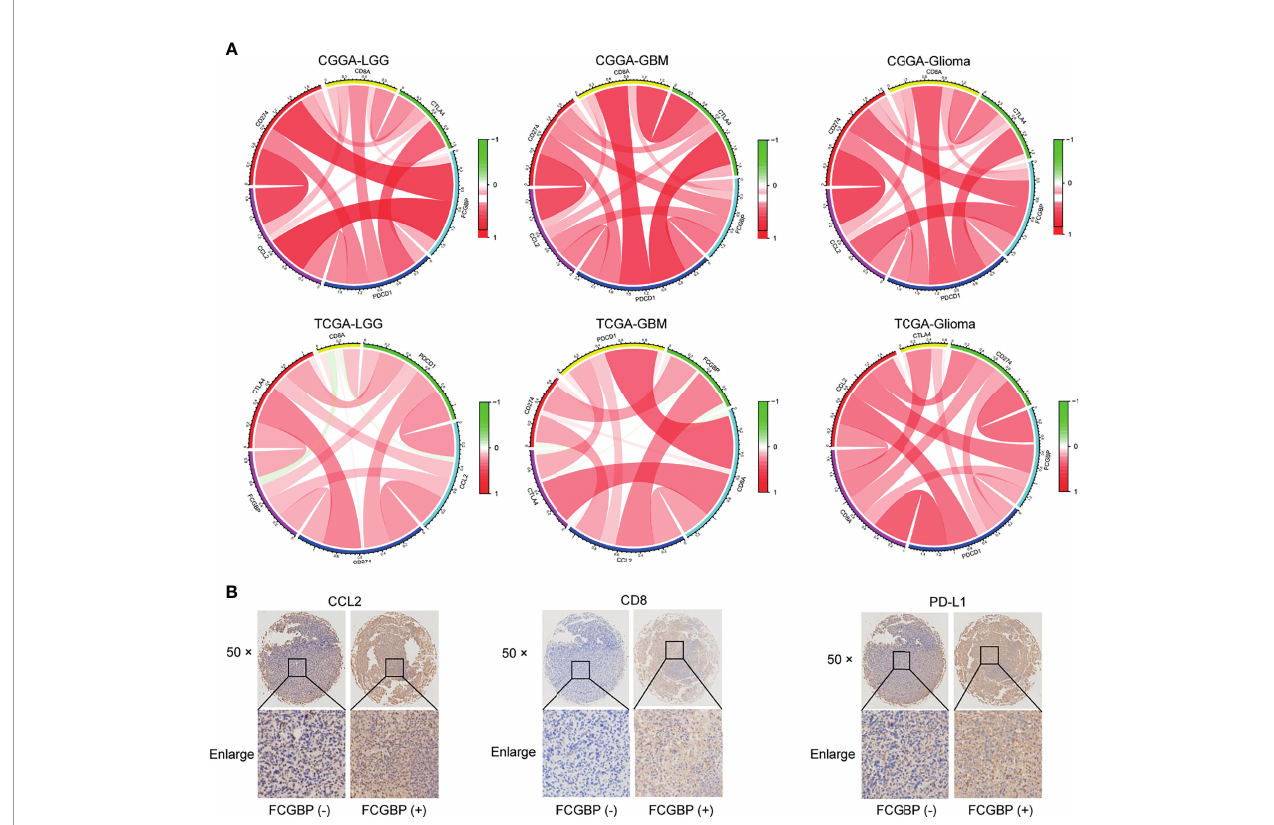
FIGURE 8 | Tissue Microarrays (TMAs) and Immunohistochemistry (IHC). (A) The chord diagram illustrating the correlation of the expression of FCGBP with CD8, CCL2 and immune checkpoints molecules (CTLA4, PD1, PDL1). (B) IHC staining of CCL2, CD8 and PDL1 in glioma